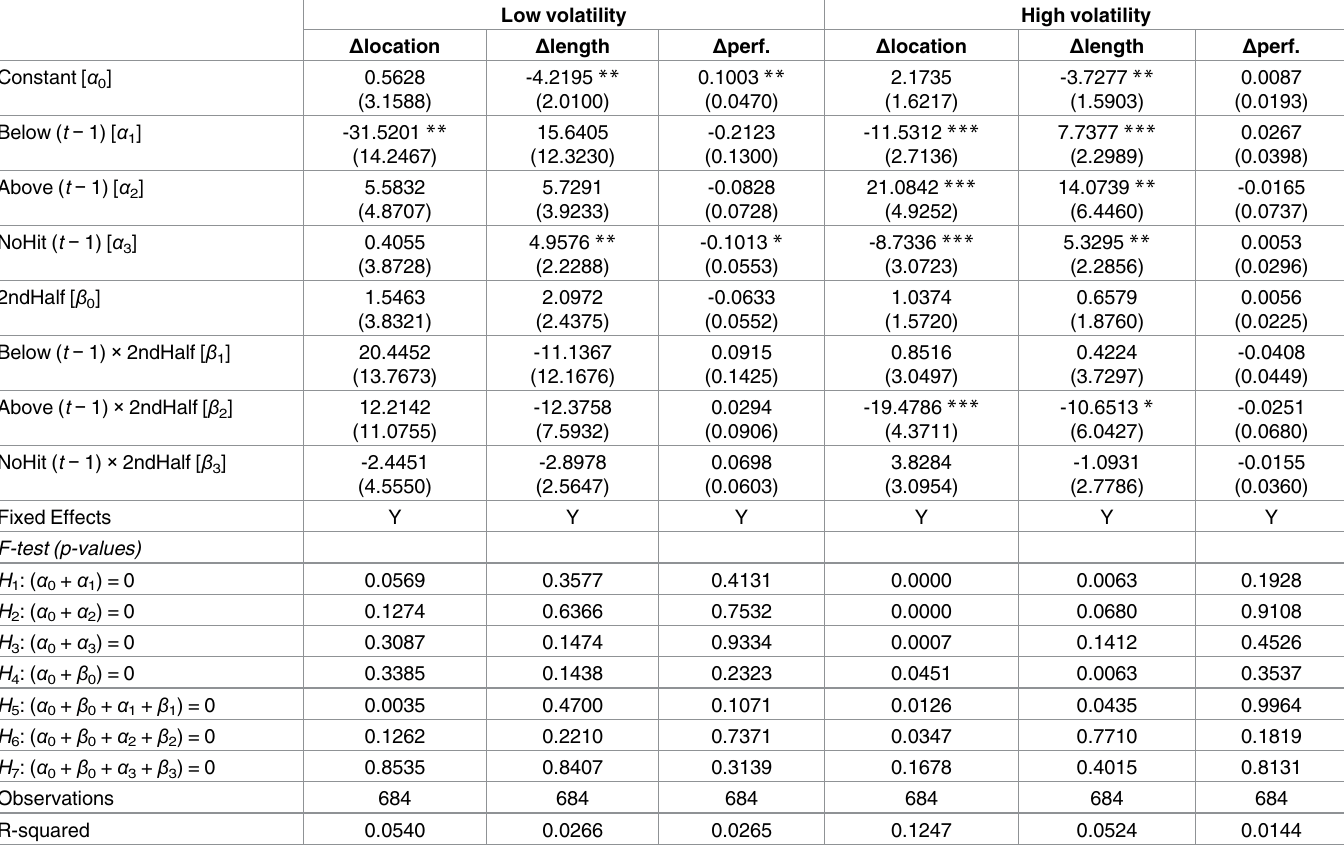
Table 4. Interval updating depending on the experiences in the previous